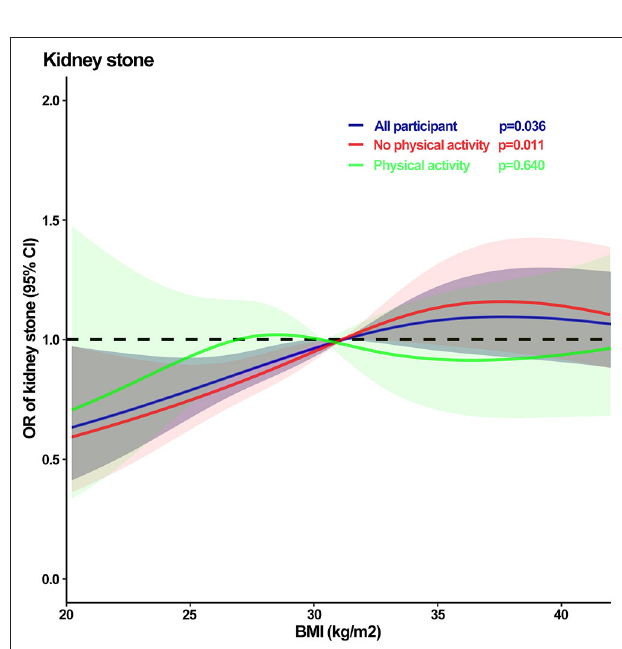
for kidney stones ( p = 0.342), and the risk of kidney stones in the BMI ≥ 30 kg/m 2 group was 1.421 compared to the BMI <